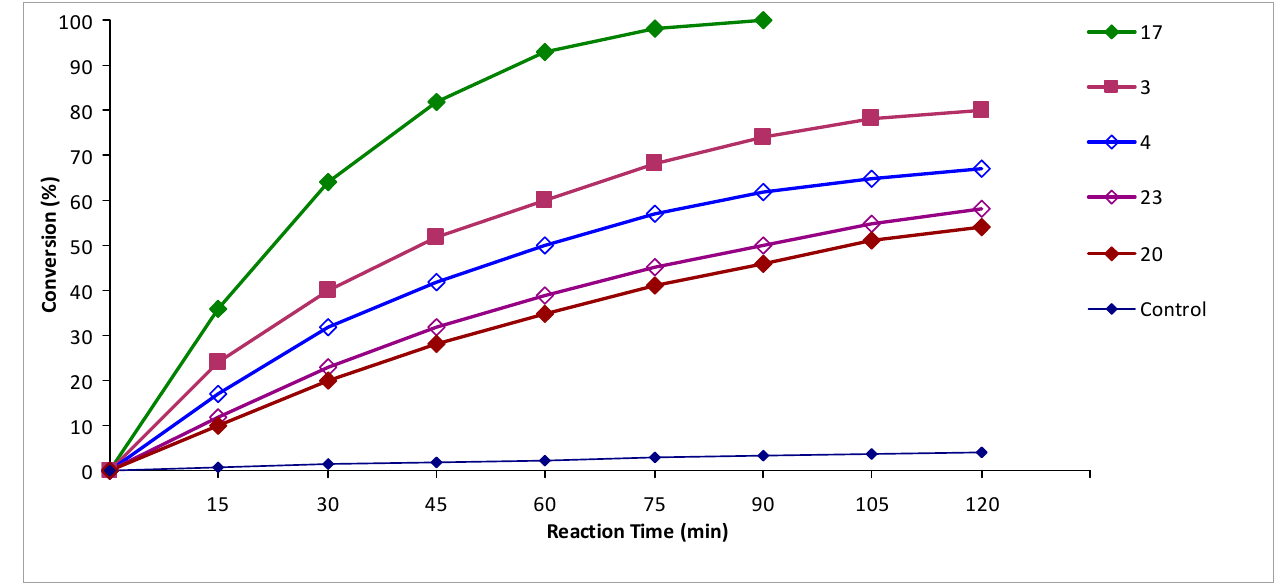
Figure 2. The evaluation of the glutathione peroxidase-like activity of the obtained water-soluble compounds 3, 4, 17, 20 and 23 .